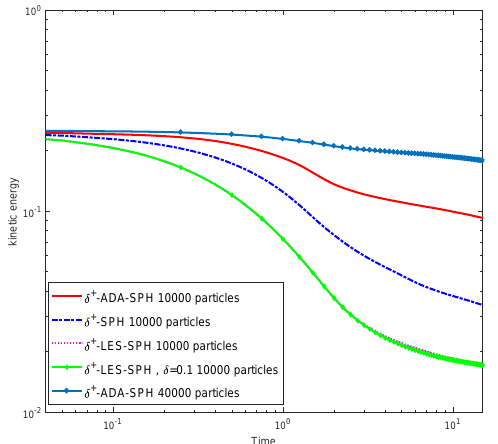
Figure 7. Inviscid two-dimensional Taylor–Green flow. Evolution of the kinetic energy using different schemes and different particle resolutions.